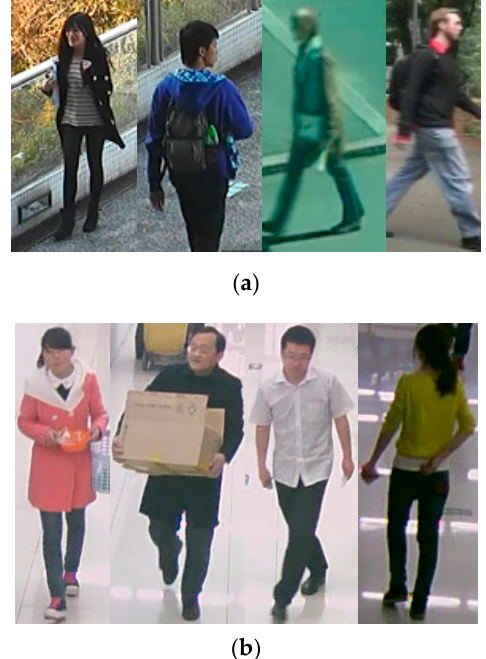
Figure 3. Examples of pedestrian images in the PETA and RAP datasets: ( a ) Sample images in the PETA dataset; ( b ) sample images in the RAP dataset.